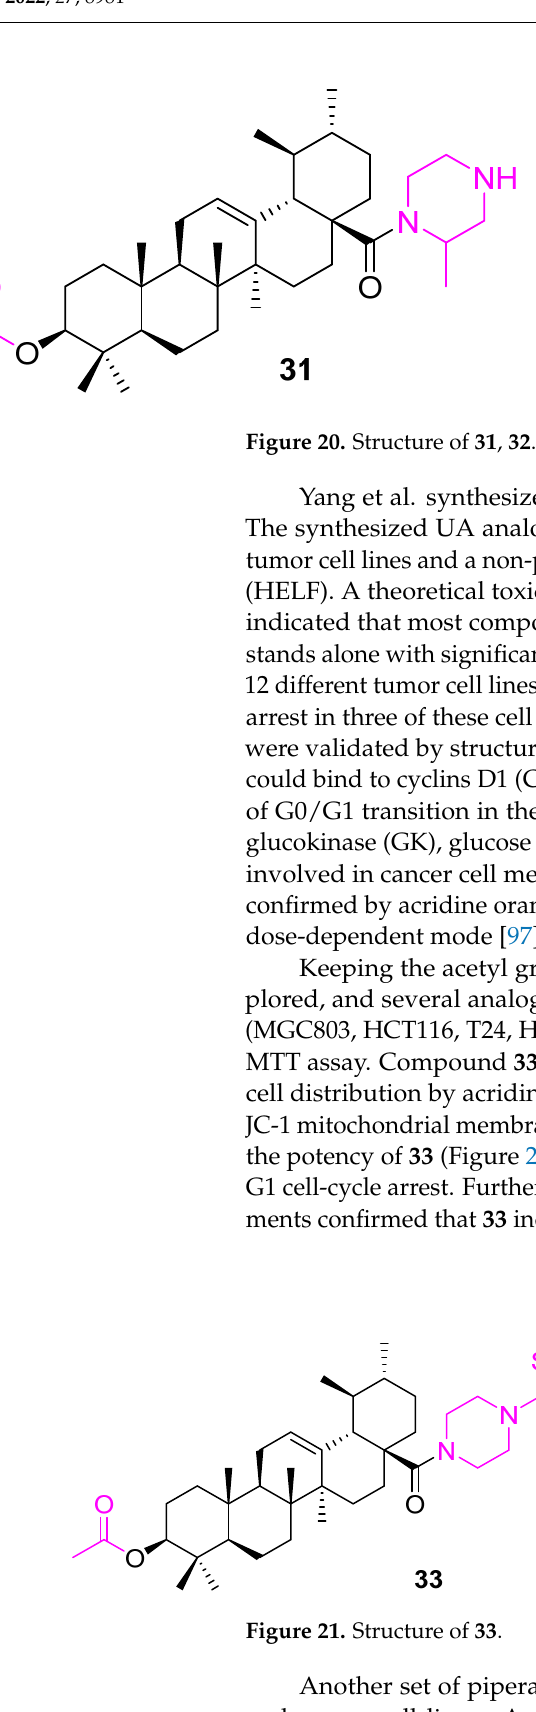
Figure 22. Structure of 34 , 35 . Transcription factor nuclear factor-kappa B (NF- κ B), known to be a regulator of a wide variety of anti-apoptotic proteins, is commonly over-expressed and constitutively activated in different types of hematologic cancers and solid tumors. NF- κ B is one of the prime targets for cancer therapy. A series of UA analogs containing long-chain diamine moieties were designed as NF- κ B inhibitors. Compound 36 shows anticancer potential against the test tumor cell lines including multidrug-resistant human cancer lines, with the IC 50 values ranging from 5.22 to 8.95 μ M. A further mechanistic study revealed com- pound 36 (Figure 23) arrests the cell cycle at the G1 phase and triggered apoptosis in A549 cells through blockage of the NF- κ B signaling pathway [100].